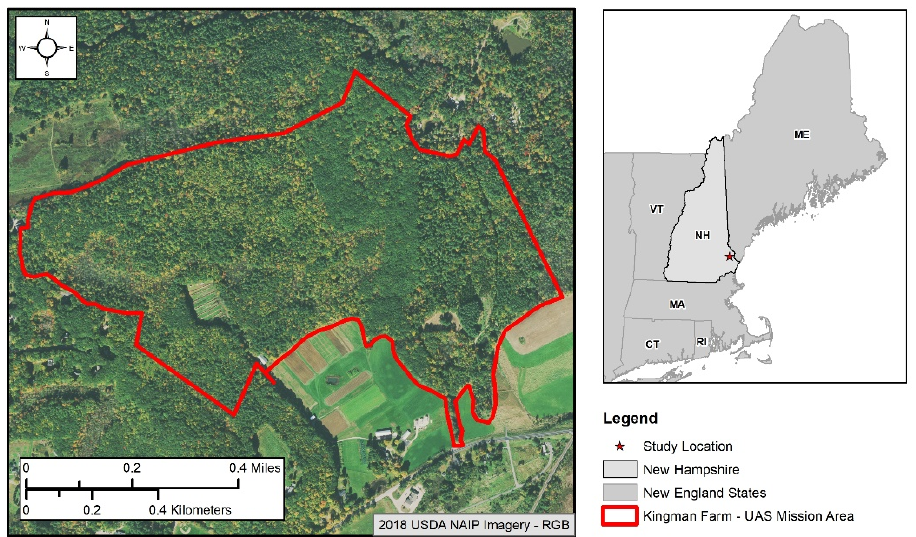
Figure 1. Study area location relative to New Hampshire and surrounding New England states. Red boundary indicates the area covered by the UAS for all data collections.